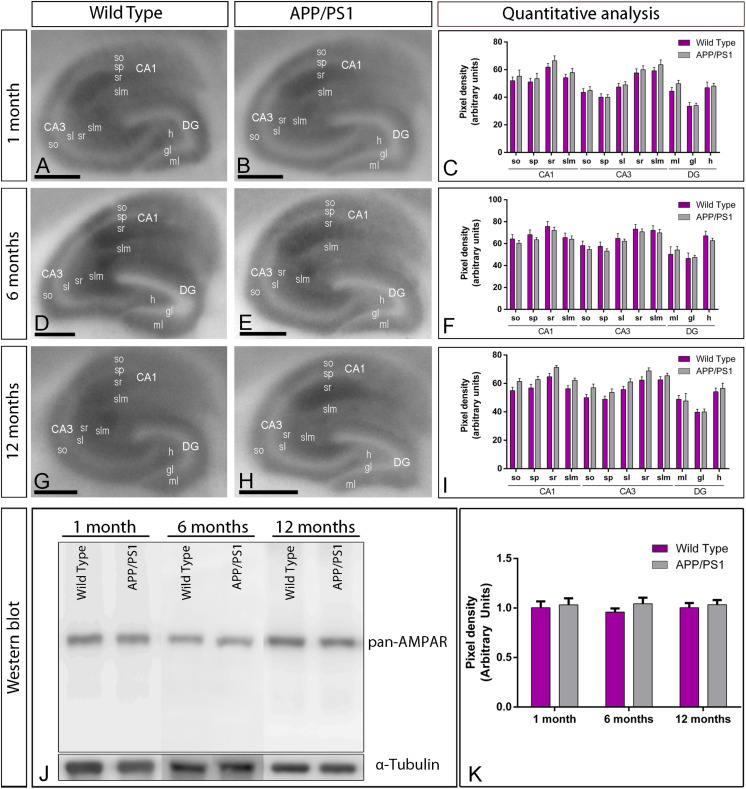
Hippocampal expression and distribution of AMPARs in wild type and APP/PS1 mice. (A–I) The expression of GluA1–4 proteins was visualized in histoblots of horizontal brain sections at 1, 6, and 12 months of age in wild type and APP/PS1 mice using an affinity-purified anti-GluA1–4 antibody. The level of AMPAR immunoreactivities in different hippocampal subfields and dendritic layers were determined by densitometric analysis of scanned histoblots. AMPAR expression was moderate to strong in all dendritic layers of the CA1 and CA3 region and dentate gyrus, with the stratum radiatum (sr) of CA1 and CA3 showing the highest expression level. Densitometric analysis showed no differences in AMPAR expression in APP/PS1 mice compared to age-matched wild type controls. Error bars indicate SEM. Scale bars: 0.05 cm. (J,K) Immunoblots showing the expression of the AMPAR protein in the hippocampus at 1, 6, and 12 months of age in wild type and APP/PS1 mice. Crude membrane preparations were probed with the anti-GluA1–4 antibody, which recognized a band with estimated molecular mass of 100 kDa. The developed immunoblots were scanned and densitometric measurements from five independent experiments (n = 4 brains) were averaged to compare the protein densities for each age and experimental group. AMPAR immunoreactivities were normalized to the α-tubulin content of each sample and expressed as pixel density. No differences were detected in APP/PS1 mice compared to age-matched wild type controls. Error bars indicate SEM.